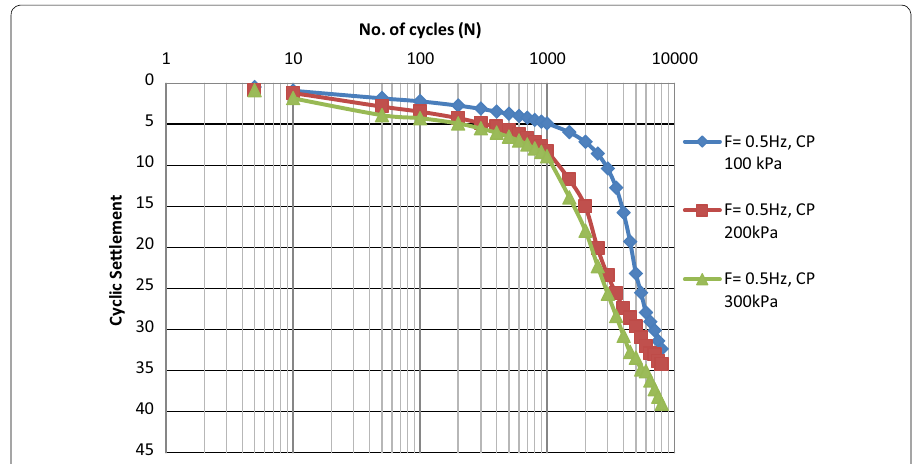
Fig. 4 Variation of cyclic settlement with cumulative number of cycles for frequency 0.5 Hz and varying cyclic pressure for unreinforced